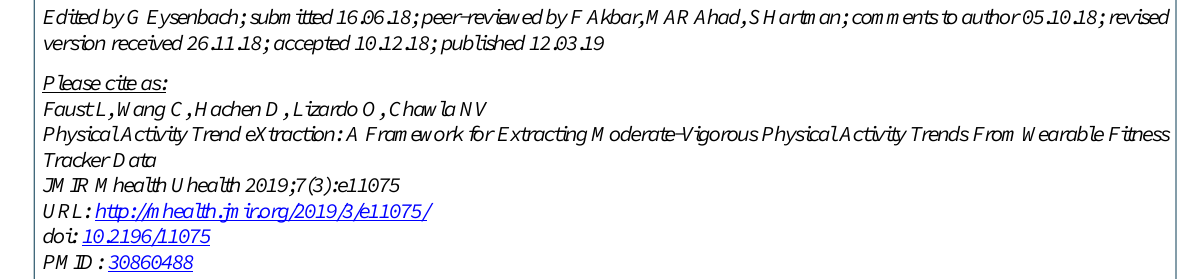
Physical Activity Trend eXtraction: A Framework for Extracting Moderate-Vigorous Physical Activity Trends From Wearable Fitness Tracker